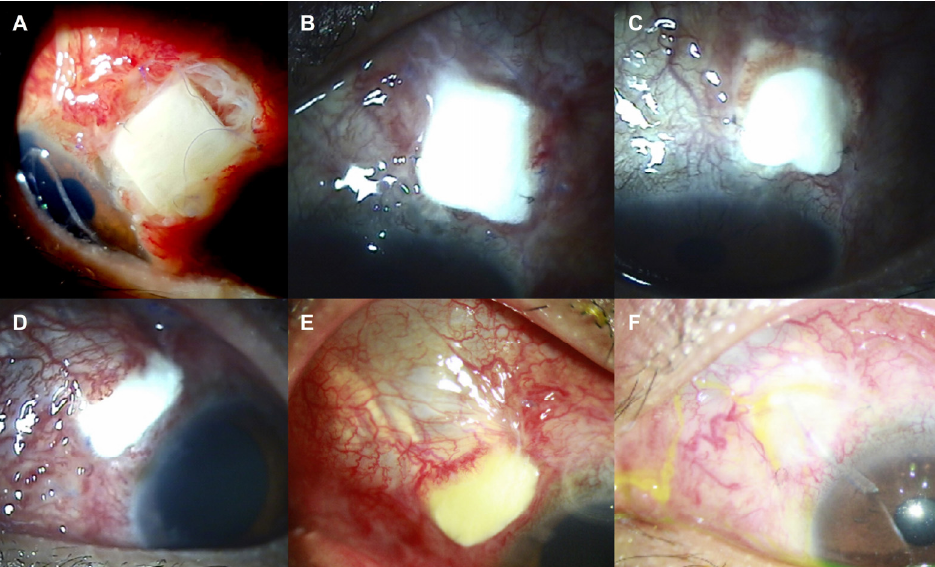
Figure 4. Slit-lamp photos of the left eye after initial ( A – C ) and secondary ( D – F ) Ahmed glaucoma valve (AGV) implantation with donor scleral patch graft. ( A – C ) Conjunctival necrosis with scleral patch exposure was observed at postoperative 1 ( A ), 2 ( B ), and 3 ( C ) months after initial AGV implantation. (D-F) Conjunctival necrosis with scleral patch exposure was detected again at postoperative 1 week ( A ) and 1 month ( B ) after secondary AGV implantation. ( F ) Conjunctival defects were healed at postoperative 4 months along with the conjunctival thinning.